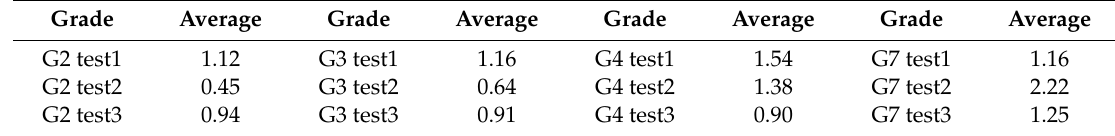
Table 3. Changes in the average apparent depth in all students over 2